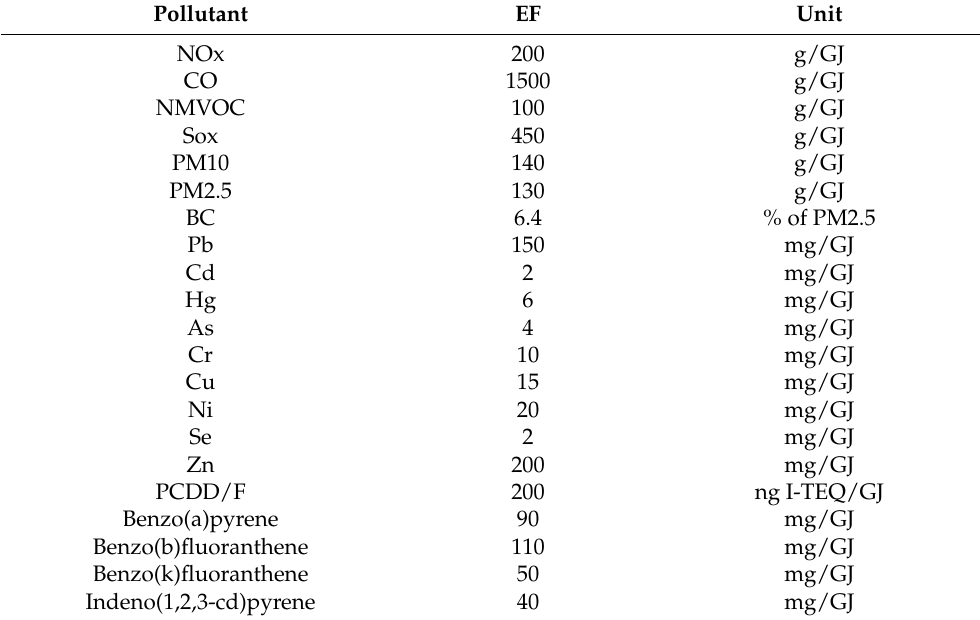
Table A2. Emission factors for medium-sized (>50 KWth to ≤ 1 MWth) manual boilers burning coal fuels (source: EMEP/EEA emission inventory guidebook). KWth stands for Kilowatt Thermal and Megawatt Thermal, respectively